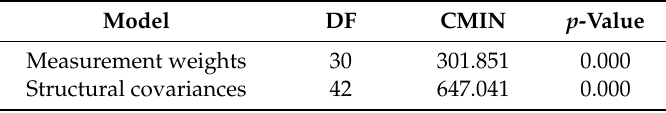
Table 6. Invariance test based on the Chi-square